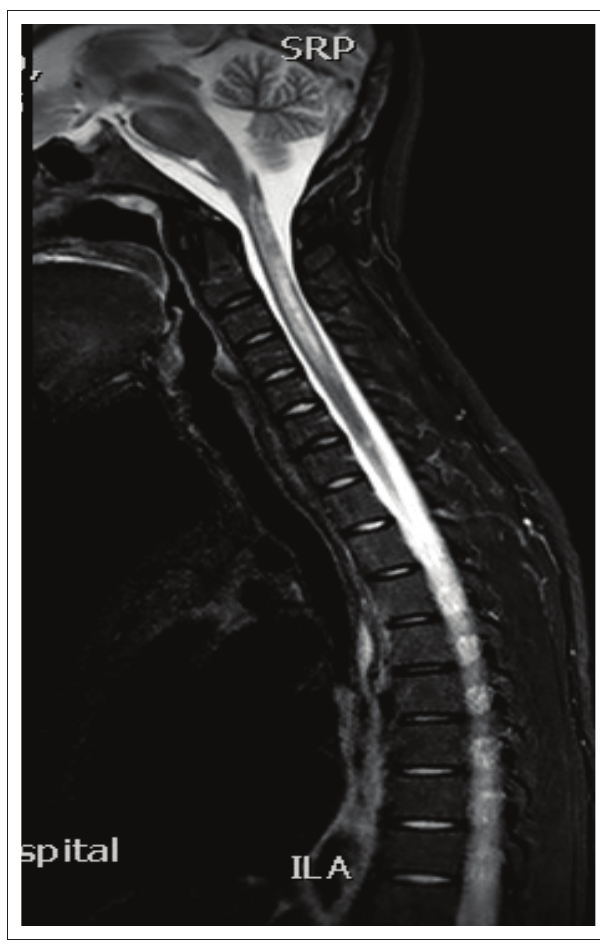
FIGURE 2: Sagittal short TI inversion recovery magnetic resonance images demonstrating longitudinally extensive spinal cord lesion.